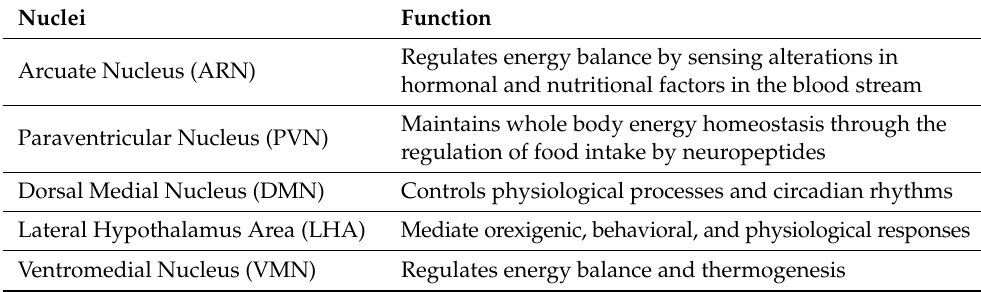
Table 2. Hypothalamus nuclei associated with controlling energy homeostasis